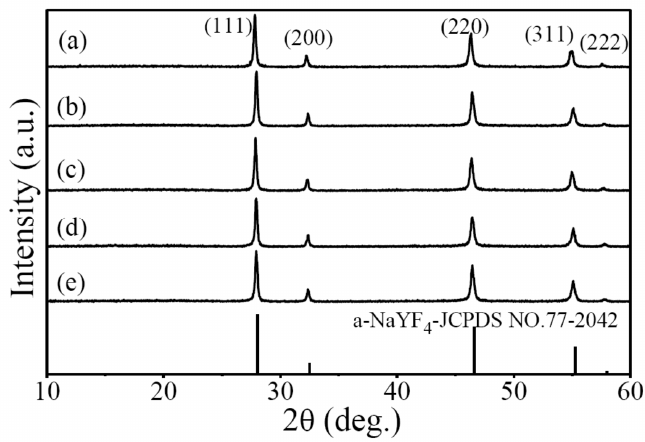
Figure 3. XRD patterns of ( a ) Eu 3+ -, ( b ) Tb 3+ -, ( c ) Ce 3+ -, ( d ) Er 3+ -, and ( e ) Tm 3+ -doped α-NaYF 4 samples calcined at 600 °C.